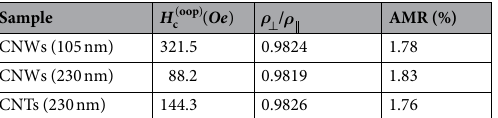
Sample H Oe ( ) coop ( )